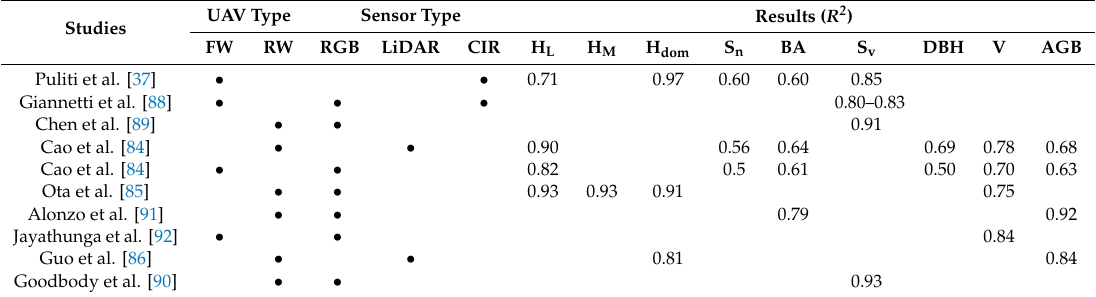
Table 1. Unmanned aerial vehicle type, sensing payloads and results from stand-level